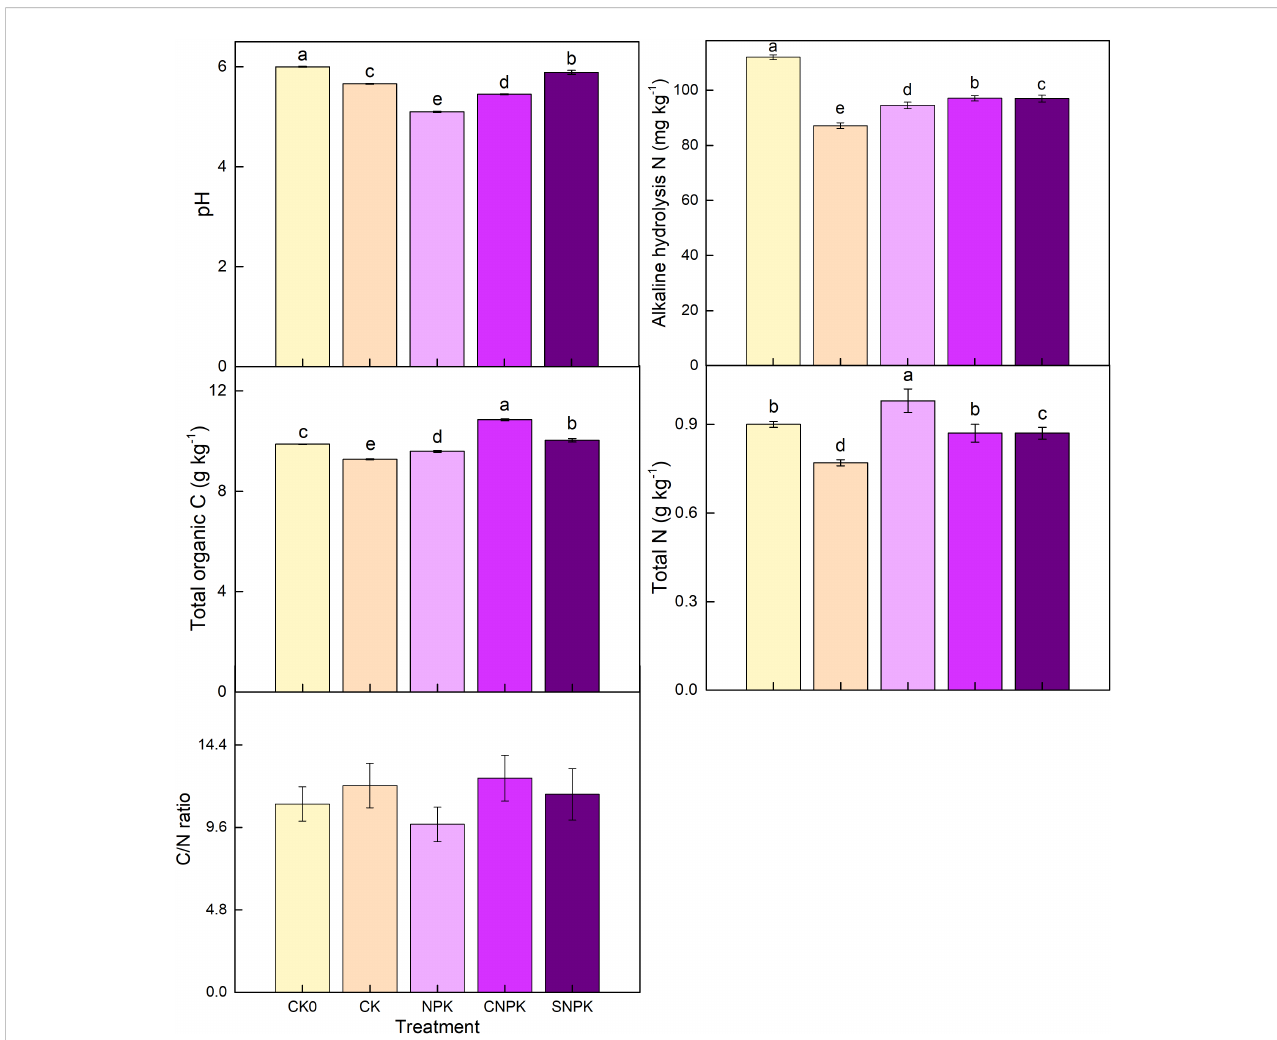
FIGURE 1 Effects of the different treatments on soil pH, alkali-hydrolyzable N, total N, total C, and C/N ratio. Error bars represent standard deviation, n = 3. Different letters in a column indicate signi fi cant differences at the 0.05 level. CK0: initial soil; CK: non-fertilizer; NPK: NPK fertilizer; CNPK: biochar + NPK fertilizer; SNPK: corn stover + NPK